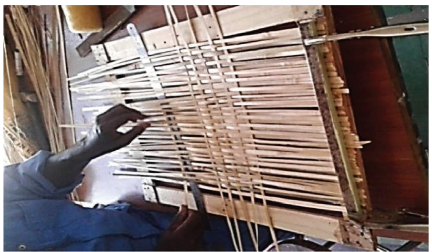
Figure 3: 0 ° and 0 ° /90 ° orientation fber weaving.